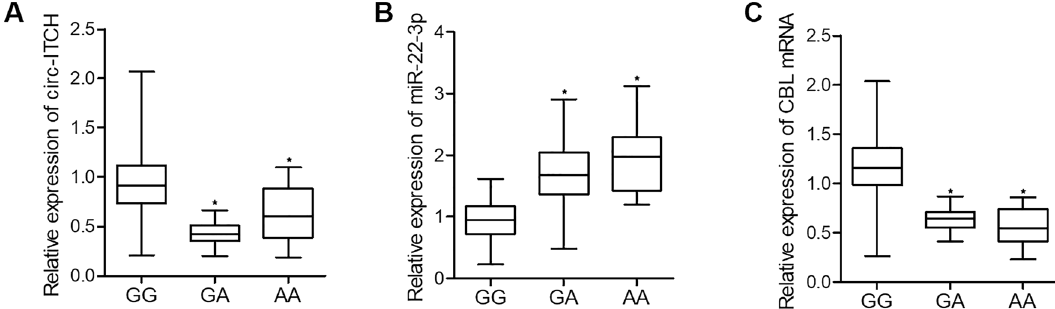
Figure 2. GG polymorphism at rs4911154 was correlated with increased expression of circ-ITCH and CBL mRNA but decreased expression of miR-22-3p in the tissue samples in thyroid nodule patients (*P value < 0.05 vs. GG group). (A) The expression of circ-ITCH was increased in patients carrying GG alleles at rs4911154 when compared with patients carrying the GA and AA genotypes. (B) The expression of miR-22-3p was decreased in patients carrying GG alleles at rs4911154 when compared with patients carrying the GA and AA genotypes. (C) The expression of CBL mRNA was increased in patients carrying GG alleles at rs4911154 when compared with patients carrying the GA and AA